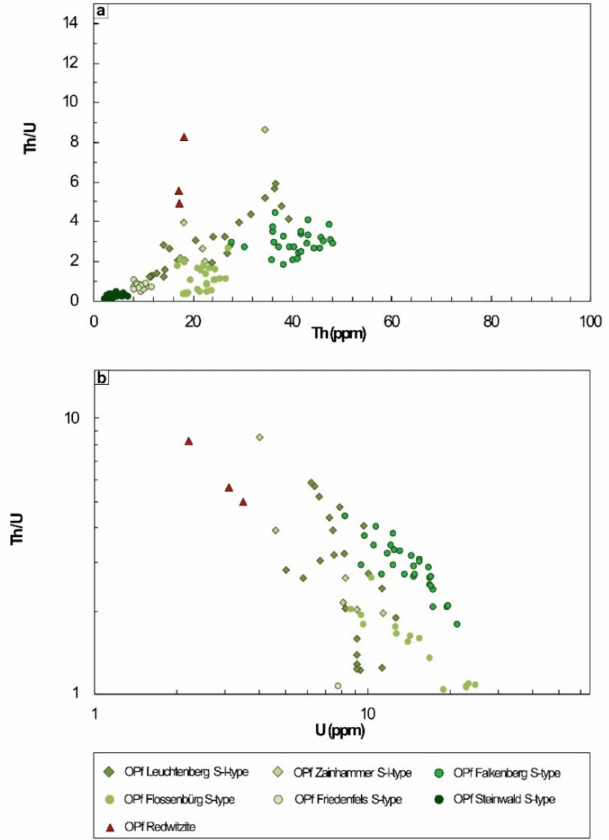
Figure 5. Th/U versus Th ( a ) and Th/U versus U ( b ) for the Oberpfalz granites and